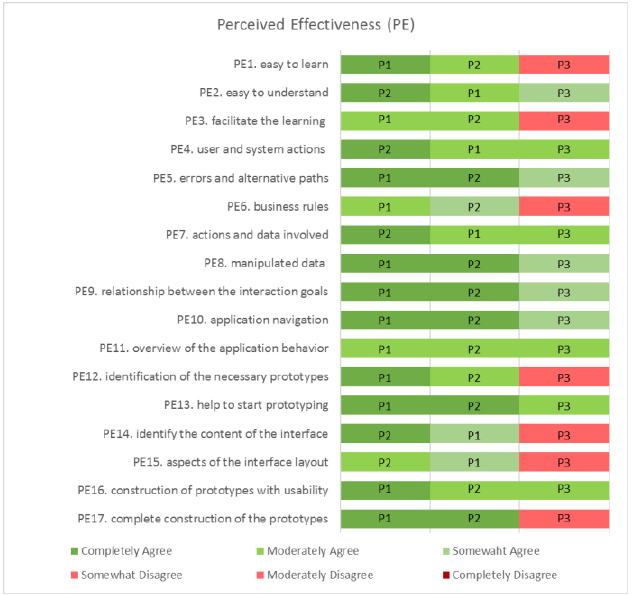
Fig 6. Perceived effectiveness from the point of view of the